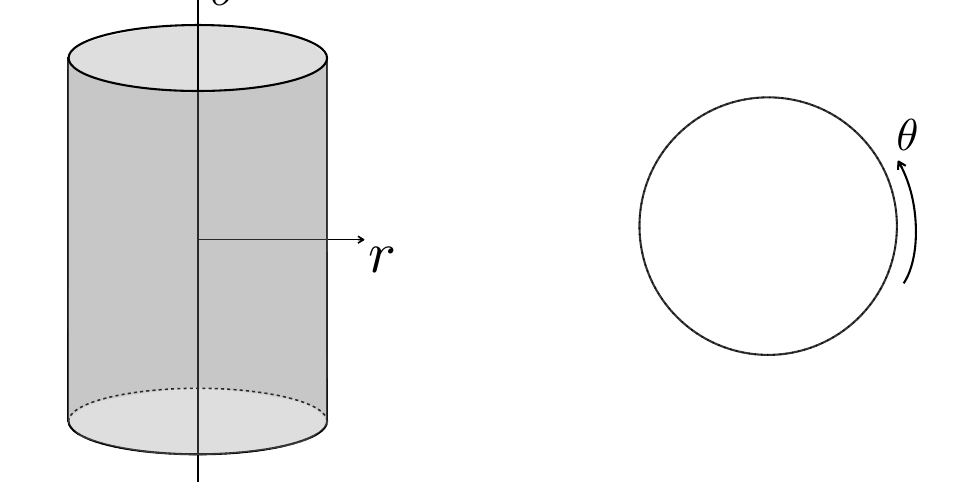
Figure 4 . Coordinates in global AdS 3 (left) and its time slice